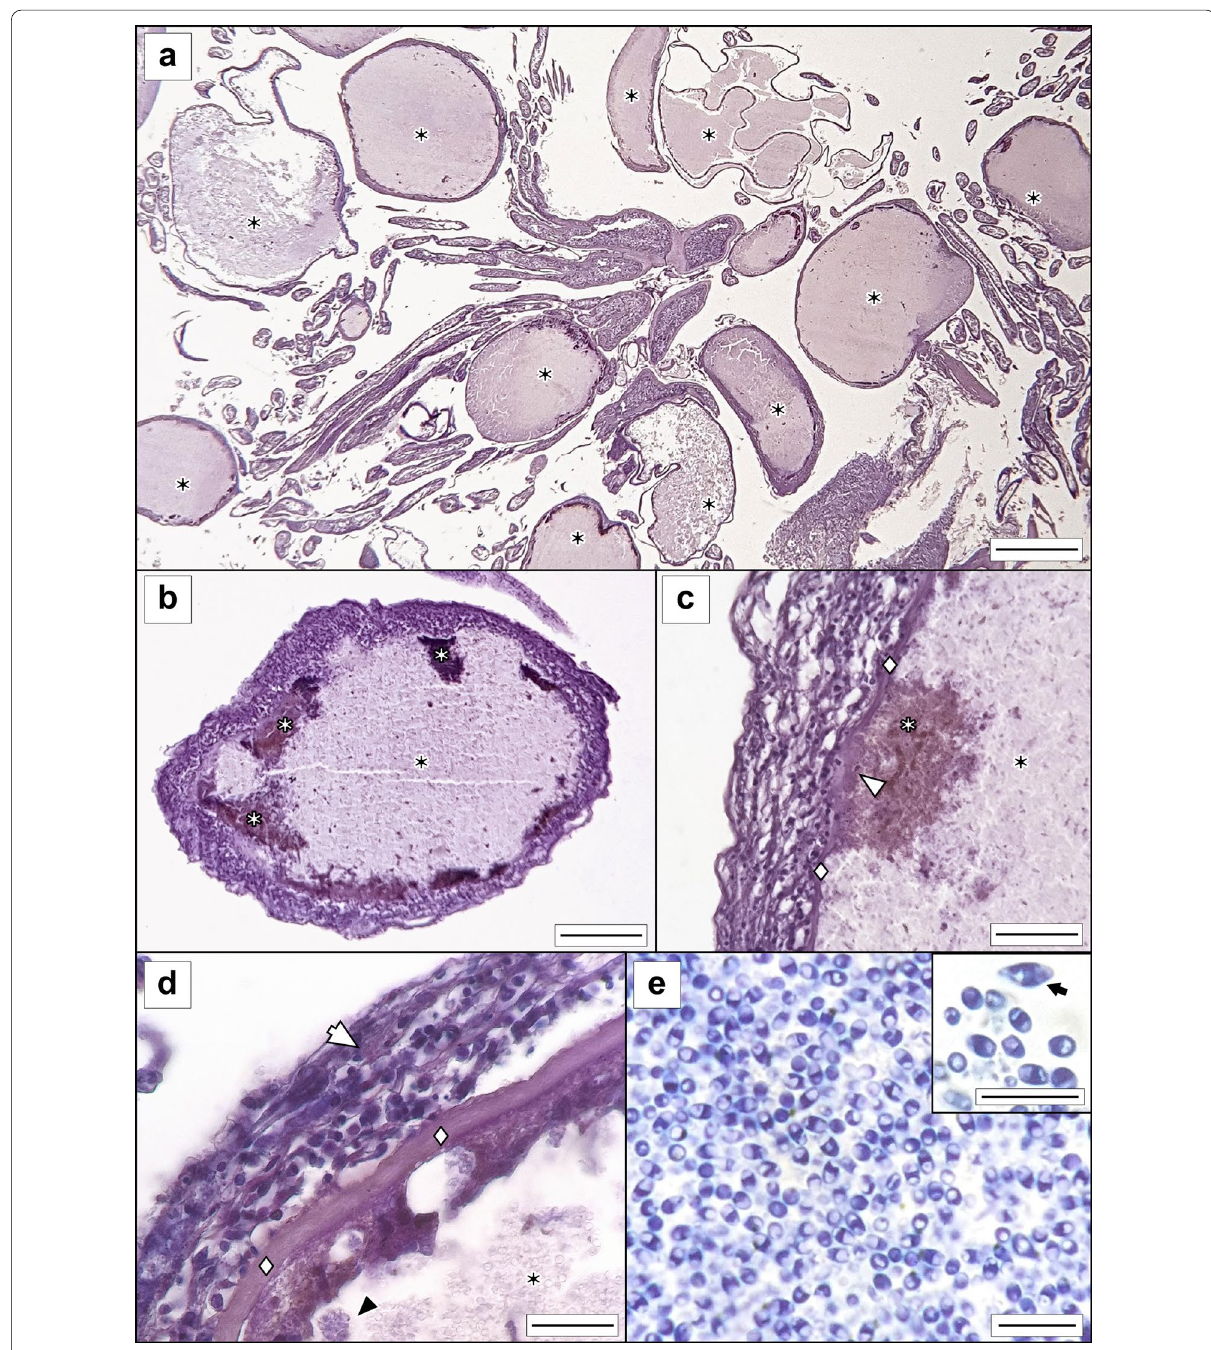
Fig. 2 Micrographs of Glugea thunni from histological sections of the caecal mass of Thunnus thynnus from the Mediterranean Sea. a G. thunni xenomas in the mesentery among the intestinal caeca (scale bar 1 mm). b Cyst of G. thunni ; xenoma exhibits peripheral spots with different degrees of melanization (scale bar 200 µm). c Detail of peripheral xenoma melanization (scale bar 70 µm). d Cyst wall with eosinophilic granule cell in the outer celular layer (scale bar 40 µm). e Microspores at the central region of xenoma (scale bar 10 µm) with a detail including an abnormal microspore (scale bar 5 µm) ( a – d , paraffin sections stained in H–W; e, semi‑thin stained in toluidine blue). White arrow—eosinophilic granule cell; black asterisk—xenoma; white asterisk—melanized spot; white diamond—acellular/fibrous layer; white arrowhead—disintegrated acellular/fibrous layer; black arrowhead—parasitophorus